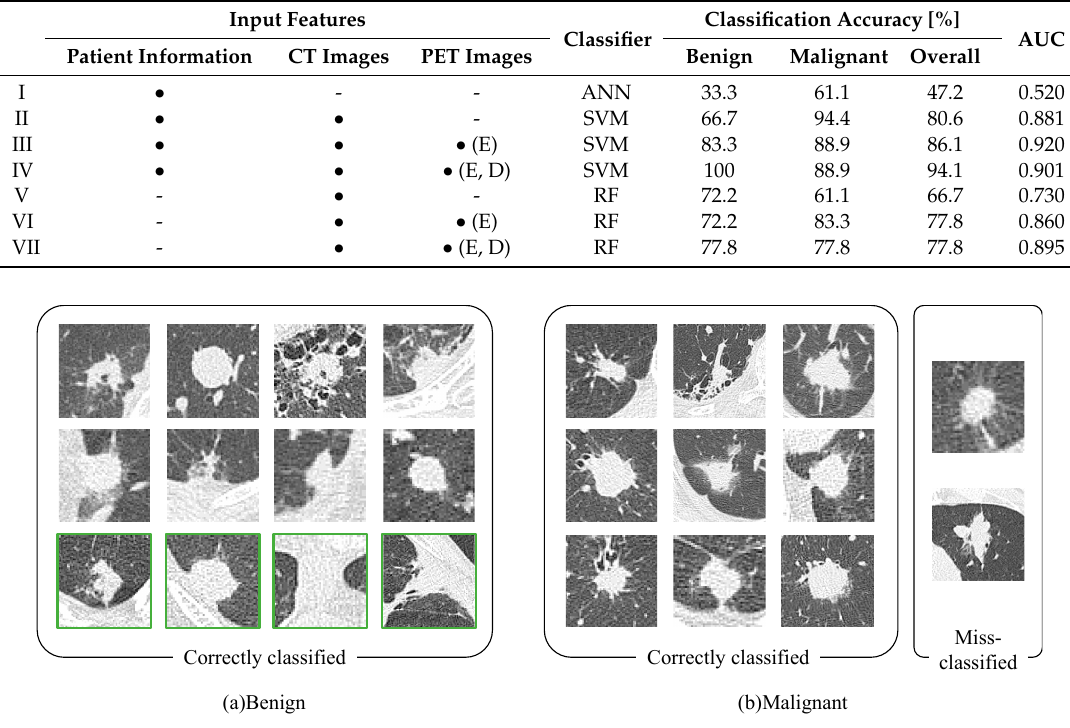
Figure 3. Classification results for Model #4 (patient information, CT images, and early-and delayed-phase PET images); ( a ) Benign; ( b ) Malignant.